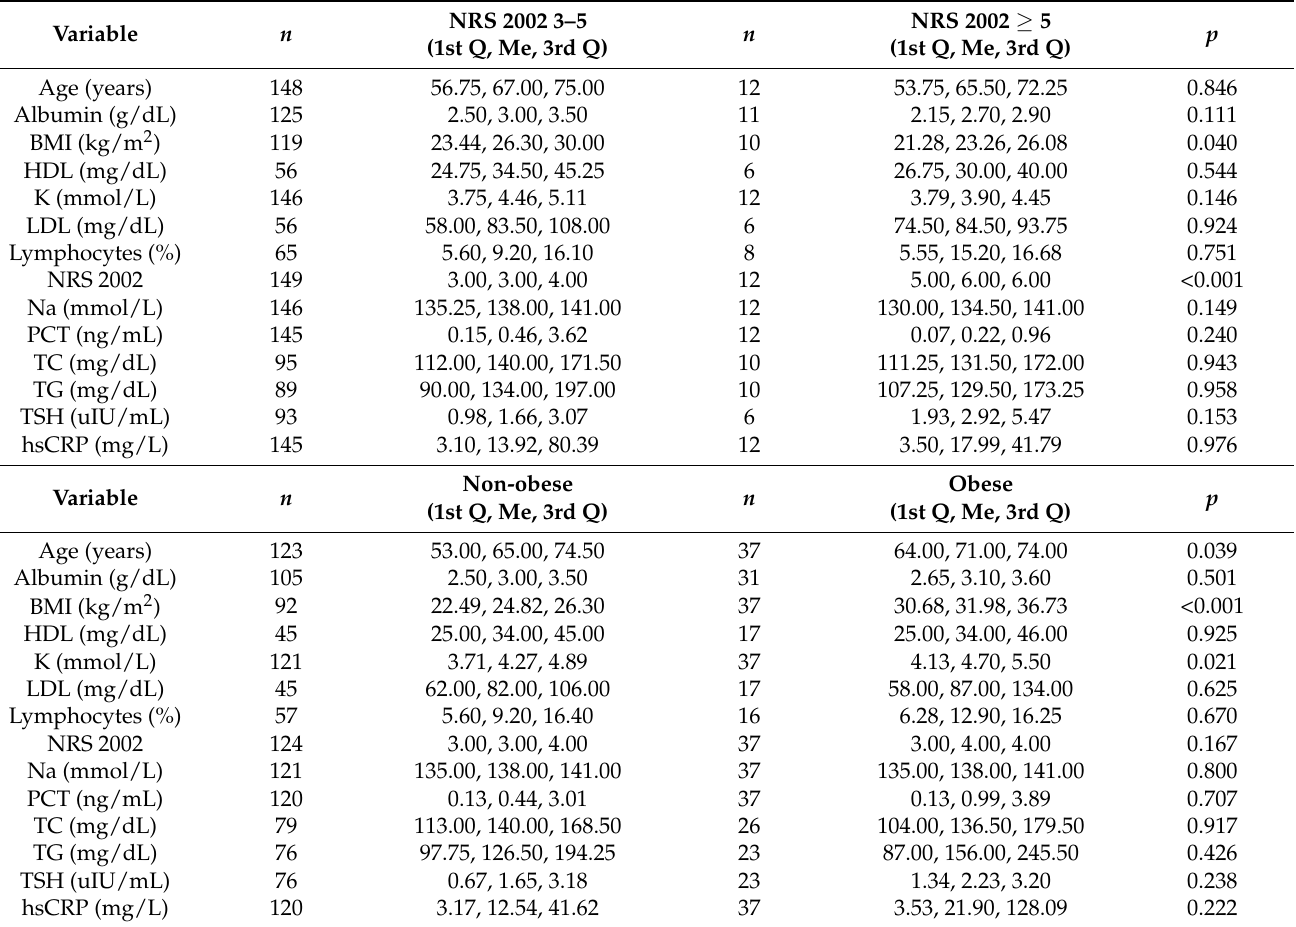
Table 2. Characteristics of the sample population and differences in malnutrition risk and obesity (continuous variables).